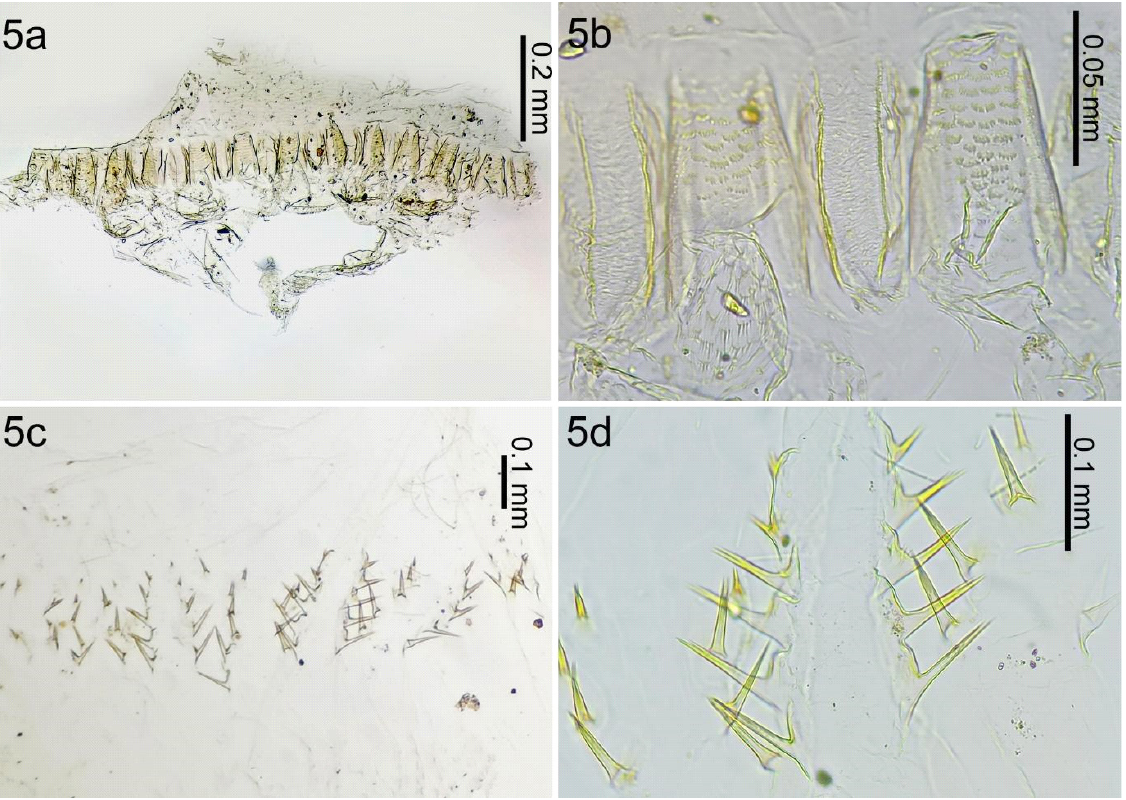
Fig 5 . Worker enteric valve and gizzard of Pericapritermes ceylonicus (Holmgren); a) Gizzard armature pads; b) Detail of the gizzard armature; c) Enteric valve armature; d) Detail of the largest